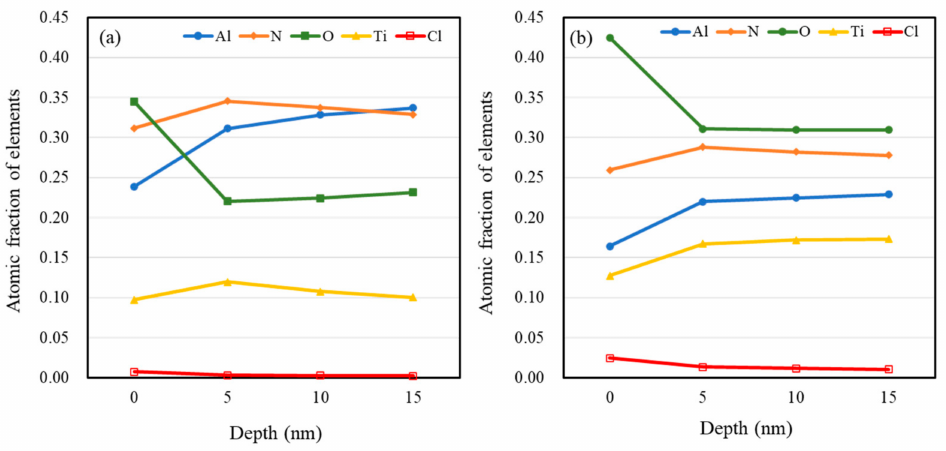
Figure 10. XPS elemental concentration profiles of ( a ) LPCVD-Ti 0.17 Al 0.83 N and ( b ) PVD-Ti 0.40 Al 0.60 N coatings after